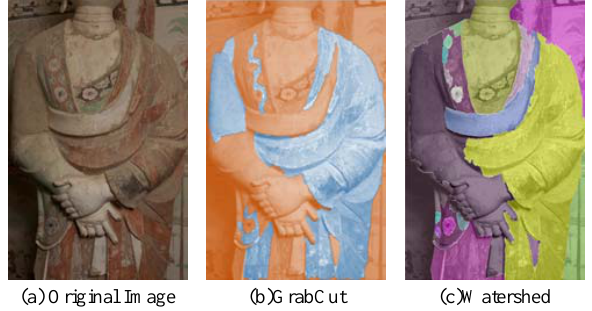
Figure 1 . Texture image segmentations is acquired with GrabCut and Watershed algorithms.